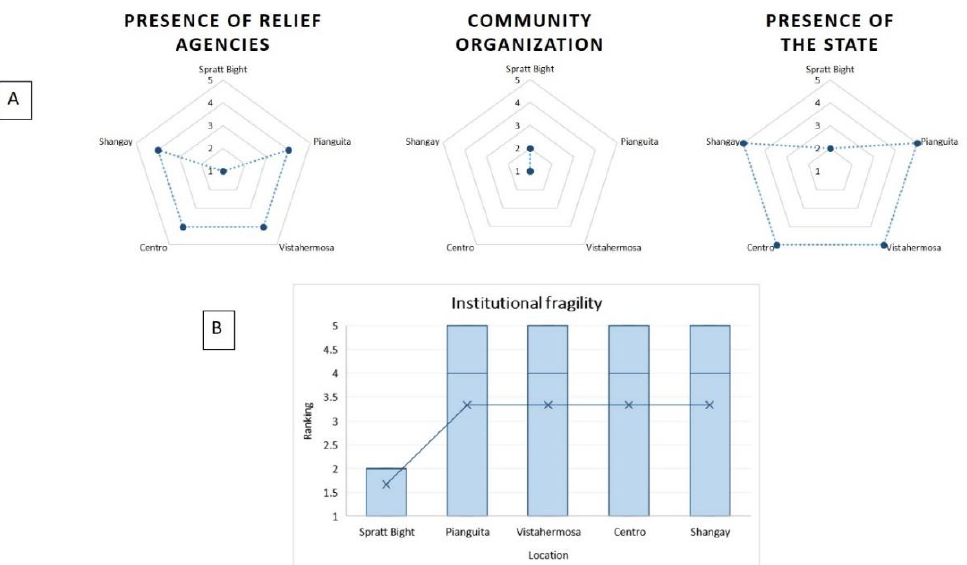
Figure 13. ( A ) Ranking of four variables representing institutional fragility for two study areas (and five villages): San Andrés, Caribbean Coast (Spratt Bight) and La Bocana, Pacific Coast (Pianguita, Vistahermosa, Centro, Shangay) of Colombia. ( B ) Minimum and maximum values of institutional fragility for each village and average rank. Results are shown by ranking, given that units of analysis are rank levels and not segments, as was the case for hazard.